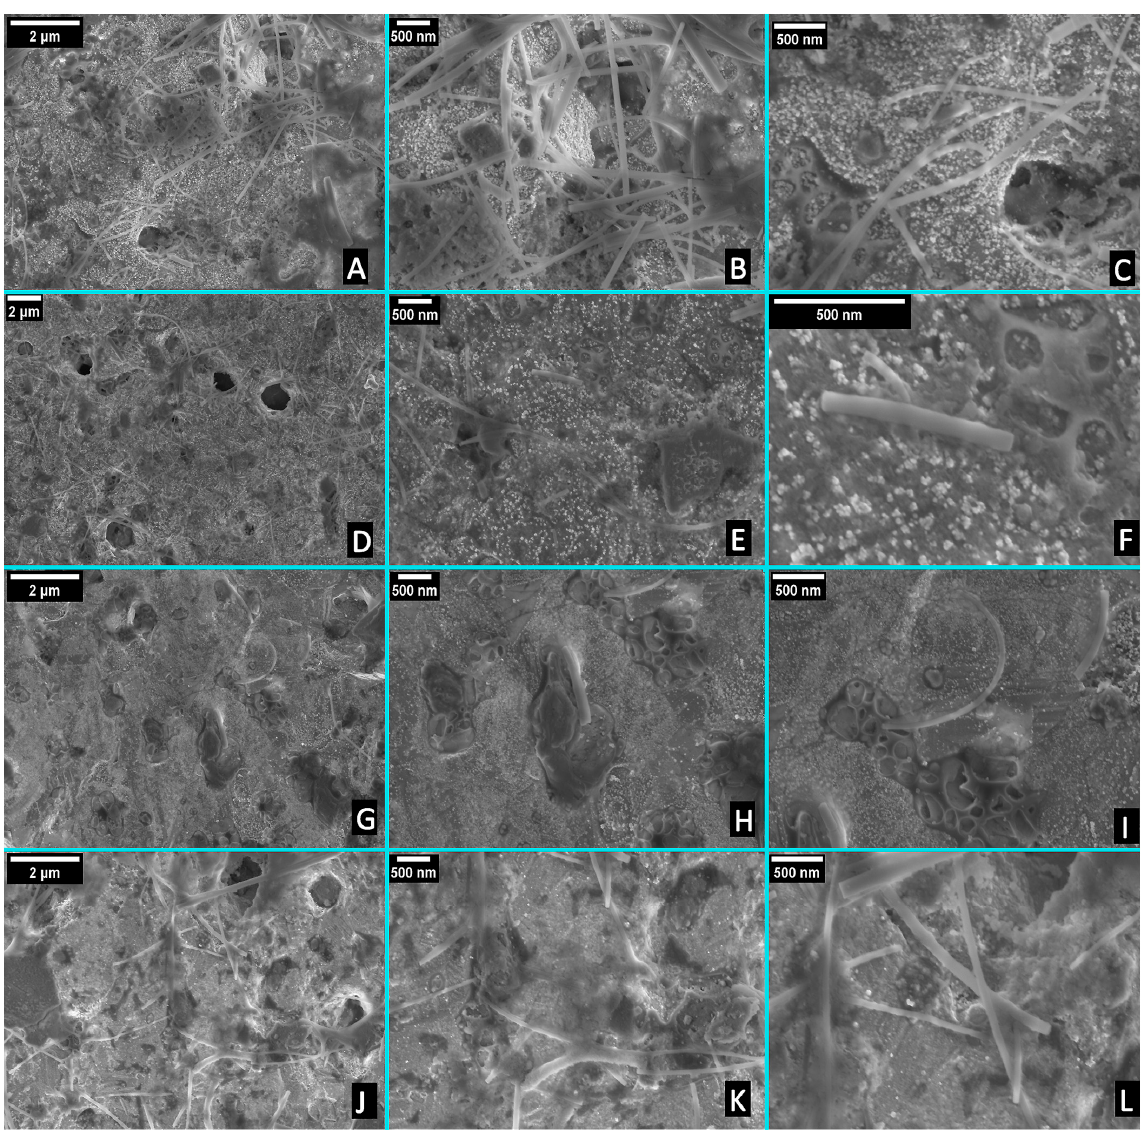
Figure 3. The SEM images for the exosomal RNAs that were isolated from; ( A – C ) MCF7, ( D – F ) MCF7/ADR, ( G – I ) SH-SY5Y, and ( J – L ) HEPG2.